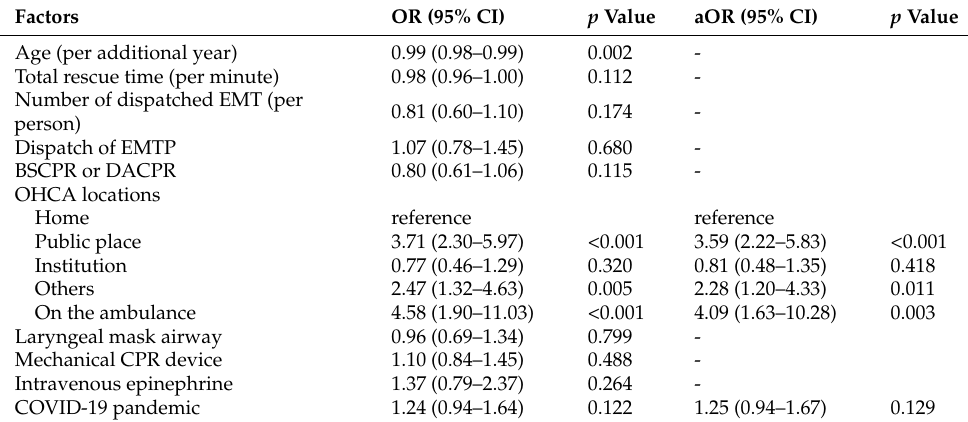
Table 2. Predictive factors of accomplishing any